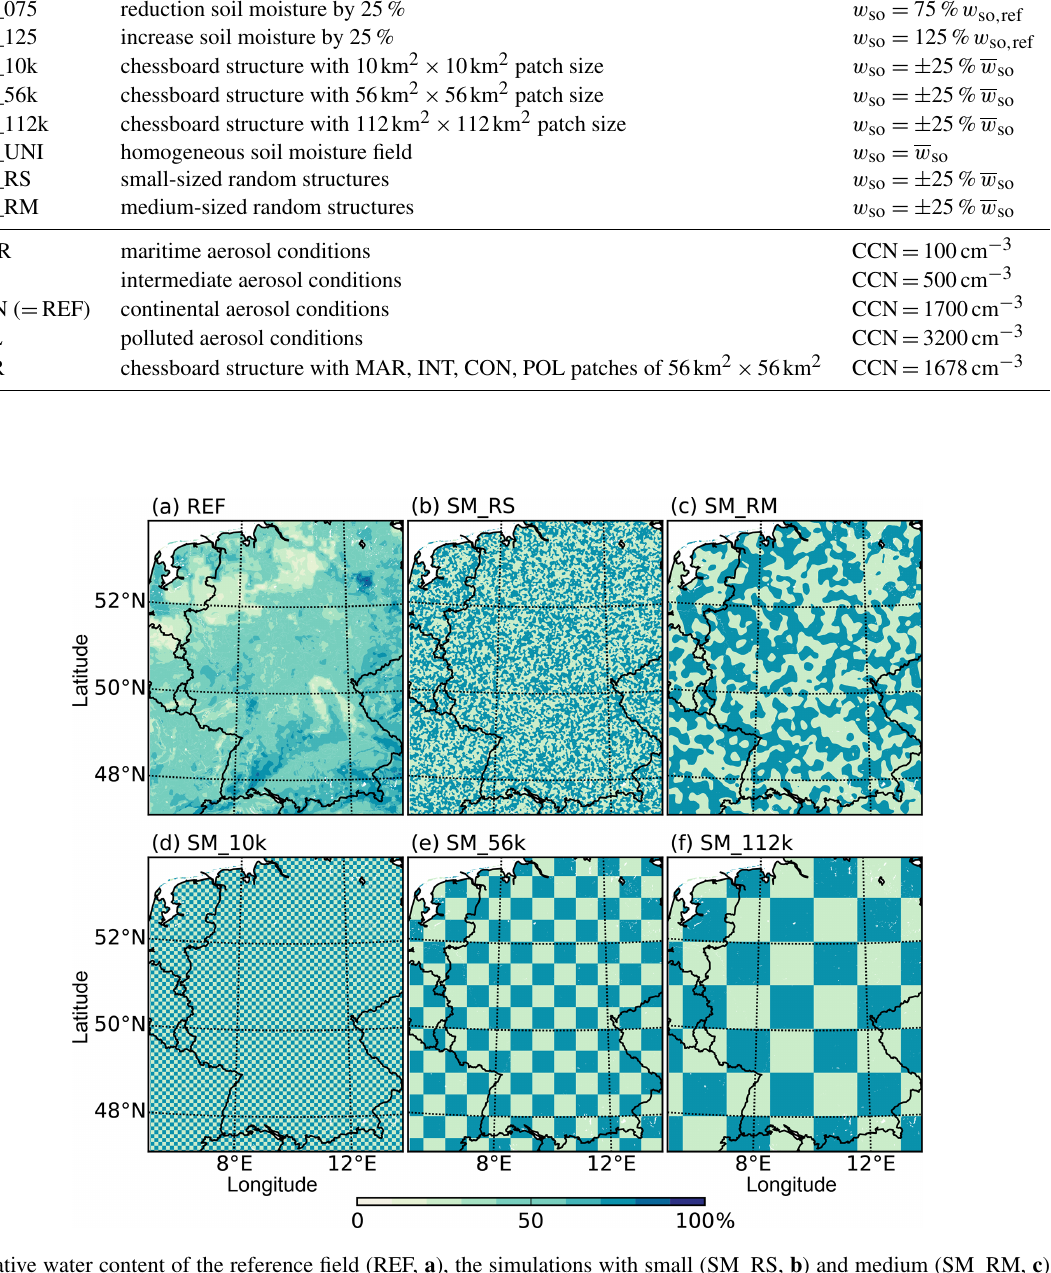
Figure 2. Relative water content of the reference field (REF, a ), the simulations with small (SM_RS, b ) and medium (SM_RM, c ) random structures, and chessboard structures with grid lengths of 10km (SM_10k, d ), 56km (SM_56k, e ), and 112km (SM_112k, f